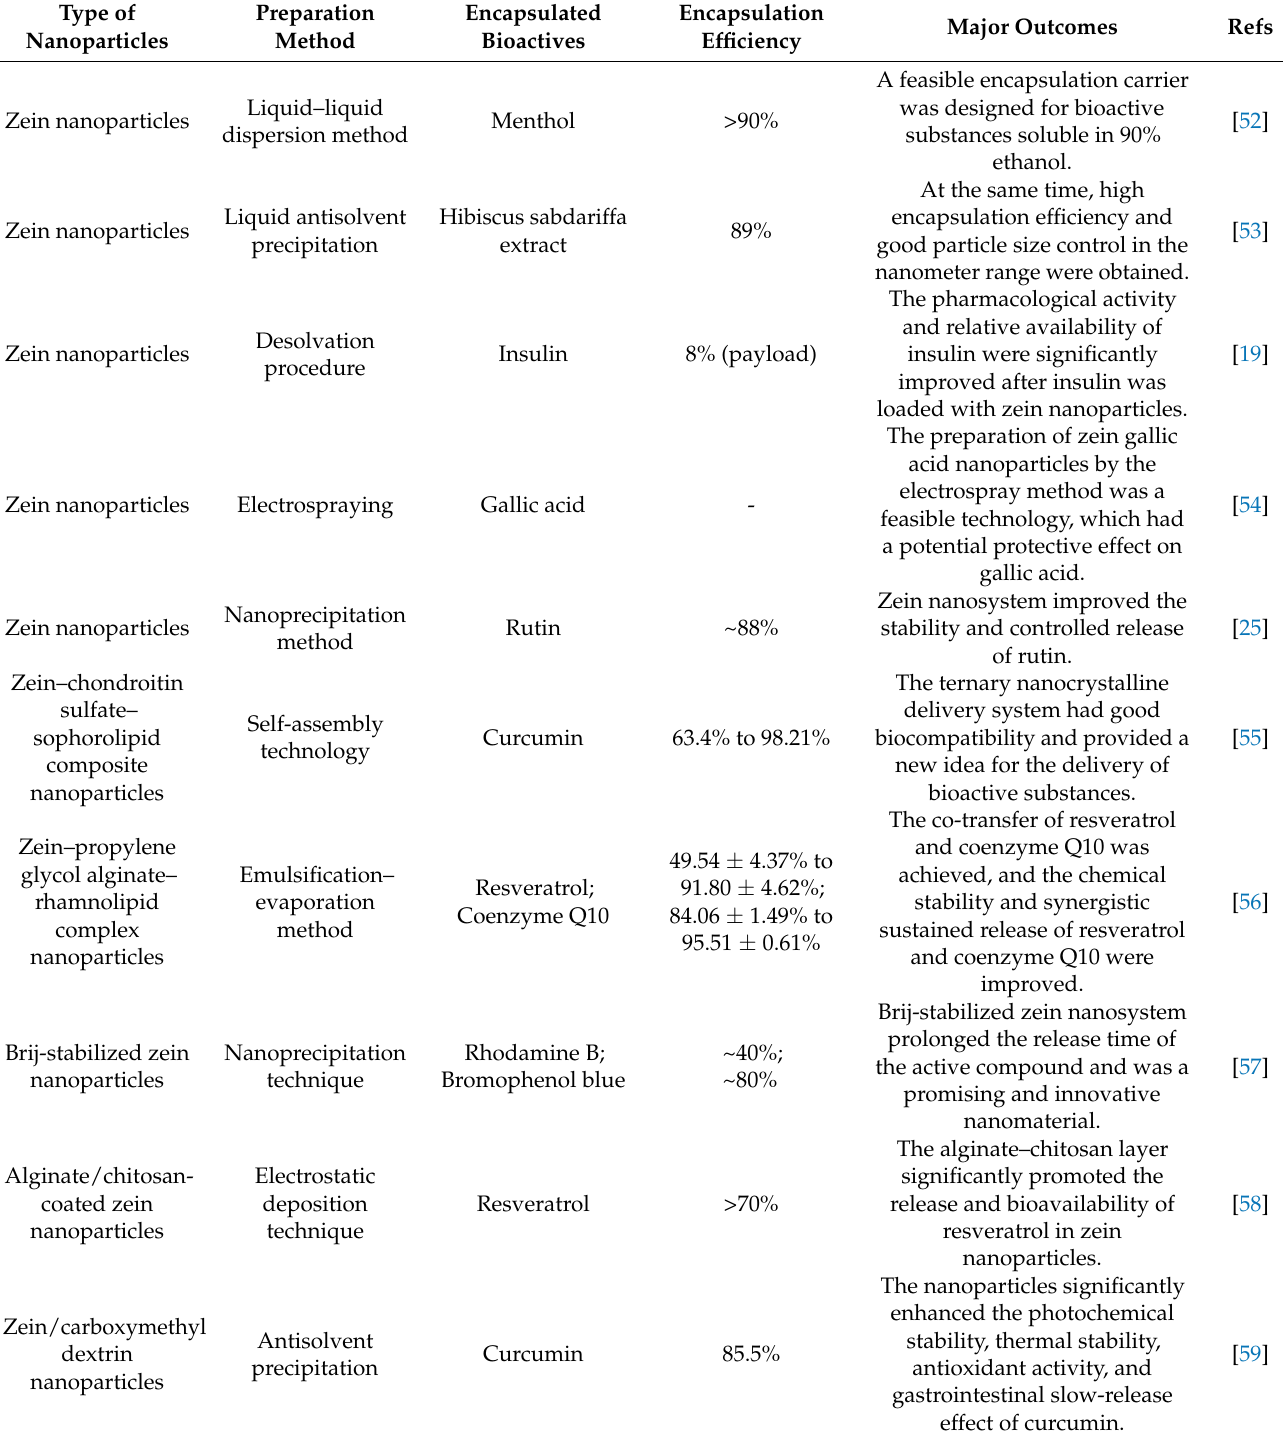
Table 1. Plant protein-based nanoparticles for bioactive ingredient